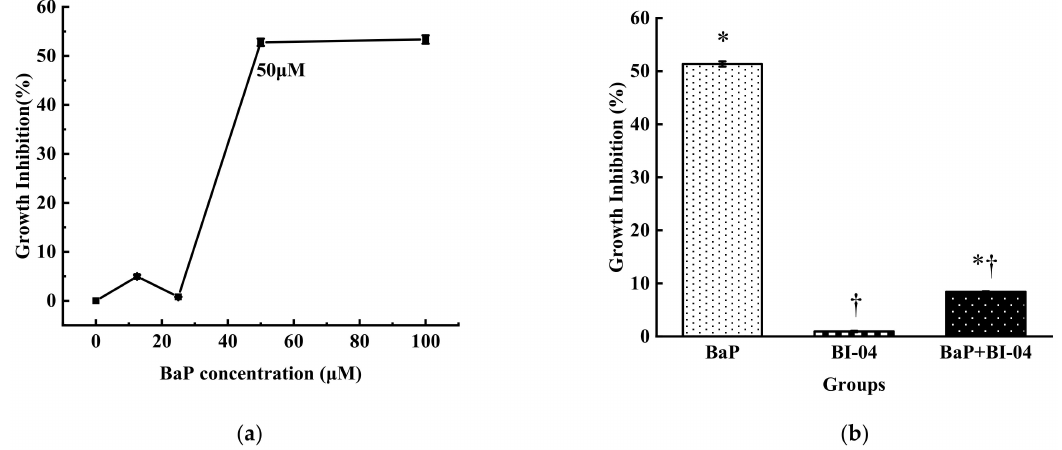
Figure 1. Relationship between BaP and the growth of colon epithelial cells. ( a ) Inhibition of BaP concentrations towards the growth of colon epithelial cells. ( b ) E ff ect of di ff erent treatments on colon epithelial cells growth. Results are expressed as mean ± standard deviation of the mean; values are mean of duplicates from three separate runs (n = 3). (* p < 0.05, significantly from control group, † p < 0.05, significantly from